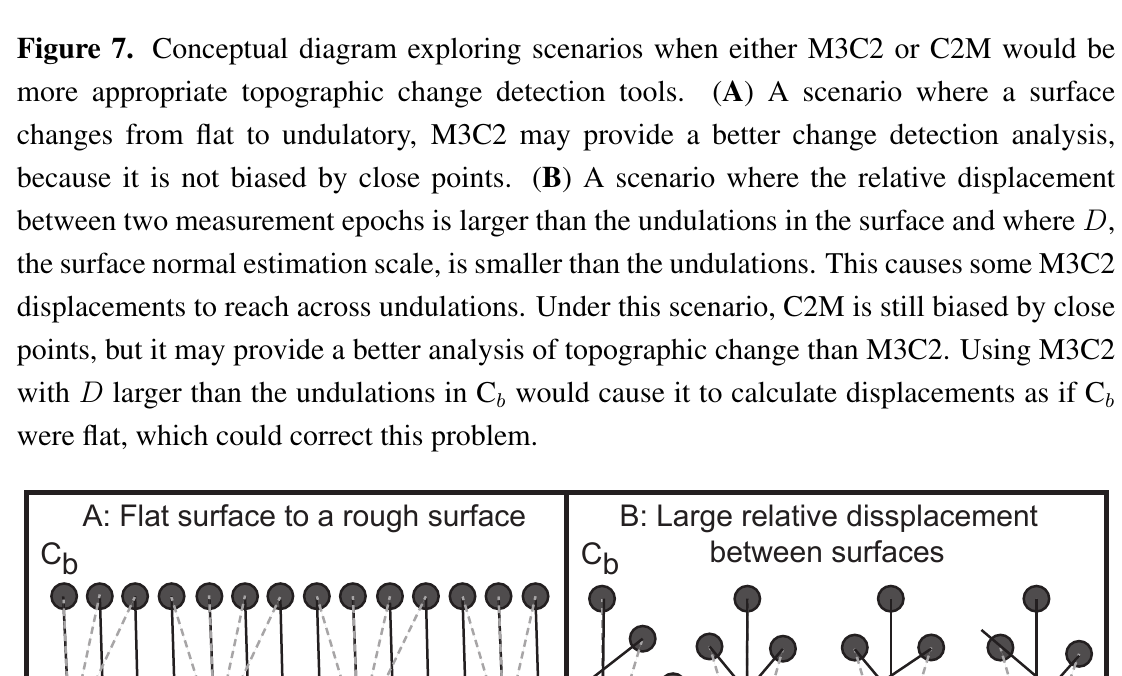
Figure 7. Conceptual diagram exploring scenarios when either M3C2 or C2M would be more appropriate topographic change detection